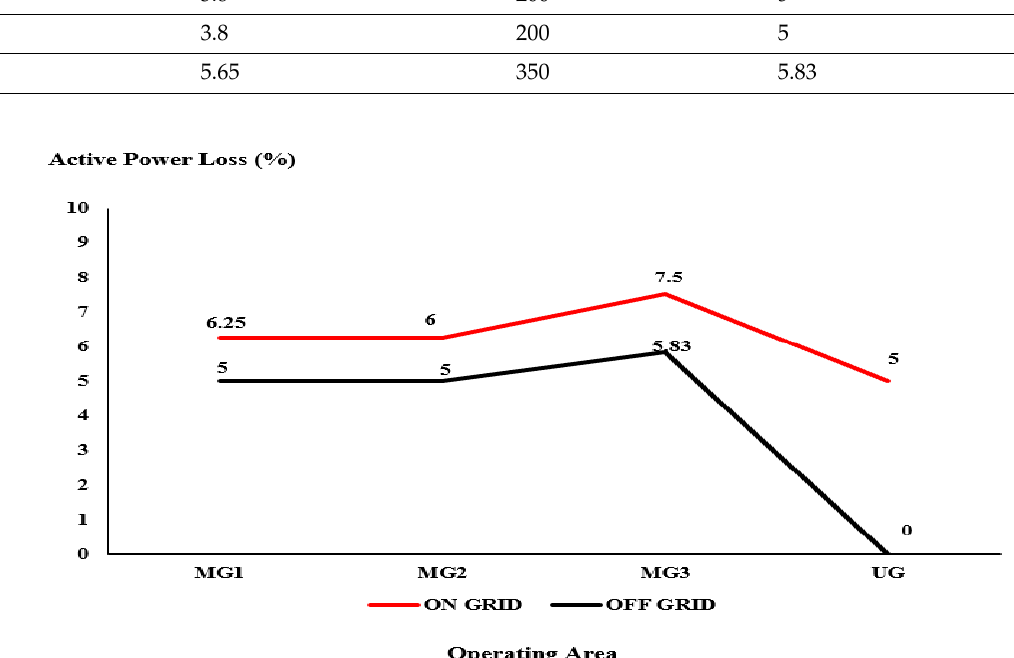
Figure 19. Loss of power in grid-tied and islanded mode by MG1, MG2, and MG3. Table 8. Allocation of power and losses between MG1, MG2, MG3, and main grid in grid-tied mode.